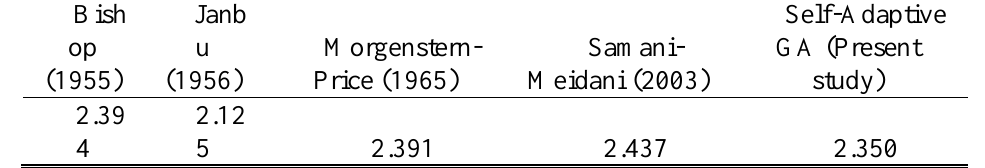
Table 4. Factor of safety calculated by various methods